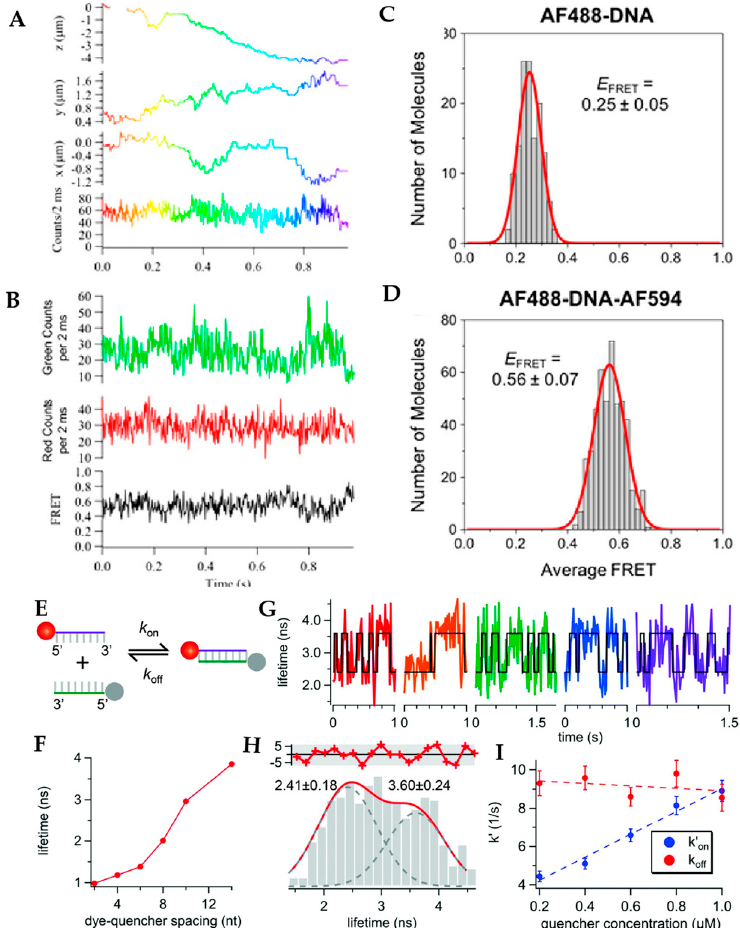
Figure 17. Tetrahedral detection tracking of intramolecular FRET within double-stranded DNA in 90% glycerol-water solution. (a) X, Y, Z position and fluorescent intensity of AF488 (Alexa Fluor 488; ex: 490 nm; em: 525 nm)-DNA-AF594 (Alexa Fluor 4594; ex: 590 nm; em: 617 nm) molecule. (b) Fluorescence intensity and FRET efficiency as a function of time for the trajectory shown in (a). (c) Distribution of FRET efficiency of AF488-DNA molecules (control sample). (d) Distribution of FRET efficiency of AF488-DNA-AF594 molecules. Reprinted with permission from reference [71]. Copyright 2018 American Chemical Society. (e-i) Measurement of the hybridization kinetics of freely diffusing ssDNA molecules in solution by tetrahedral detection 3D tracking. (e) Scheme of the donor-quencher system for the DNA hybridization kinetics measurement. Red ball denotes ATTO633 (ex: 630 nm; em: 651 nm) reporter and grey ball denotes Iowa Black quencher. (f) Fluorescence lifetimes of ATTO633 with different donor-quencher separation distances. (g) Lifetime measurement in 3D tracking of ssDNA in 70 wt% glycerol solution. The fluorescence lifetime switching indicates transient annealing and melting events. (h) Lifetime histogram built from (g) showing two states. (i) Apparent annealing rate (k on ) and melting rate (k off ) as a function of quencher concentration shows the annealing rate is quencher concentration dependent. Adapted from reference [105] . Copyright 2017 the Royal Society of Chemistry.